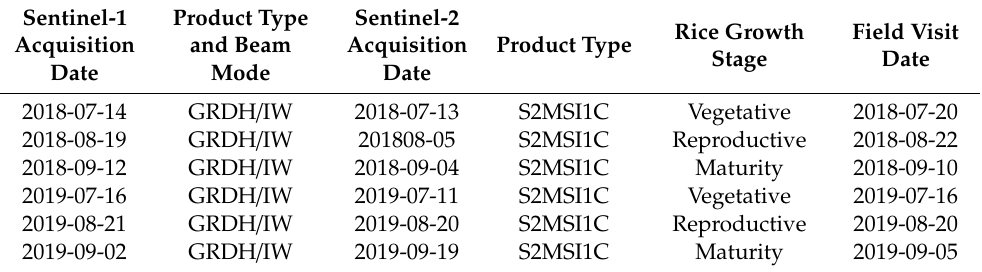
Table 1. Sentinel-1 / 2 data acquisition dates, sensor characteristics, and the rice growth stage